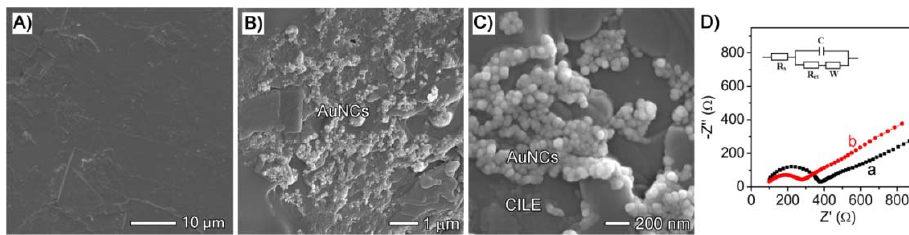
Figure 2. SEM images of a carbon ionic liquid electrode (CILE) ( A ) and AuNCs/CILE with different magnification ( B , C ); ( D ) Nyquist plots of CILE (a) and AuNCs/CILE (b) in a 10.0 mmol/L [Fe(CN) 6 ] 3 − /4 − solution containing 0.1 mol/L KCl with the frequency of 10 5 ~0.1 Hz (inset is the Randles circuit model in the cell).